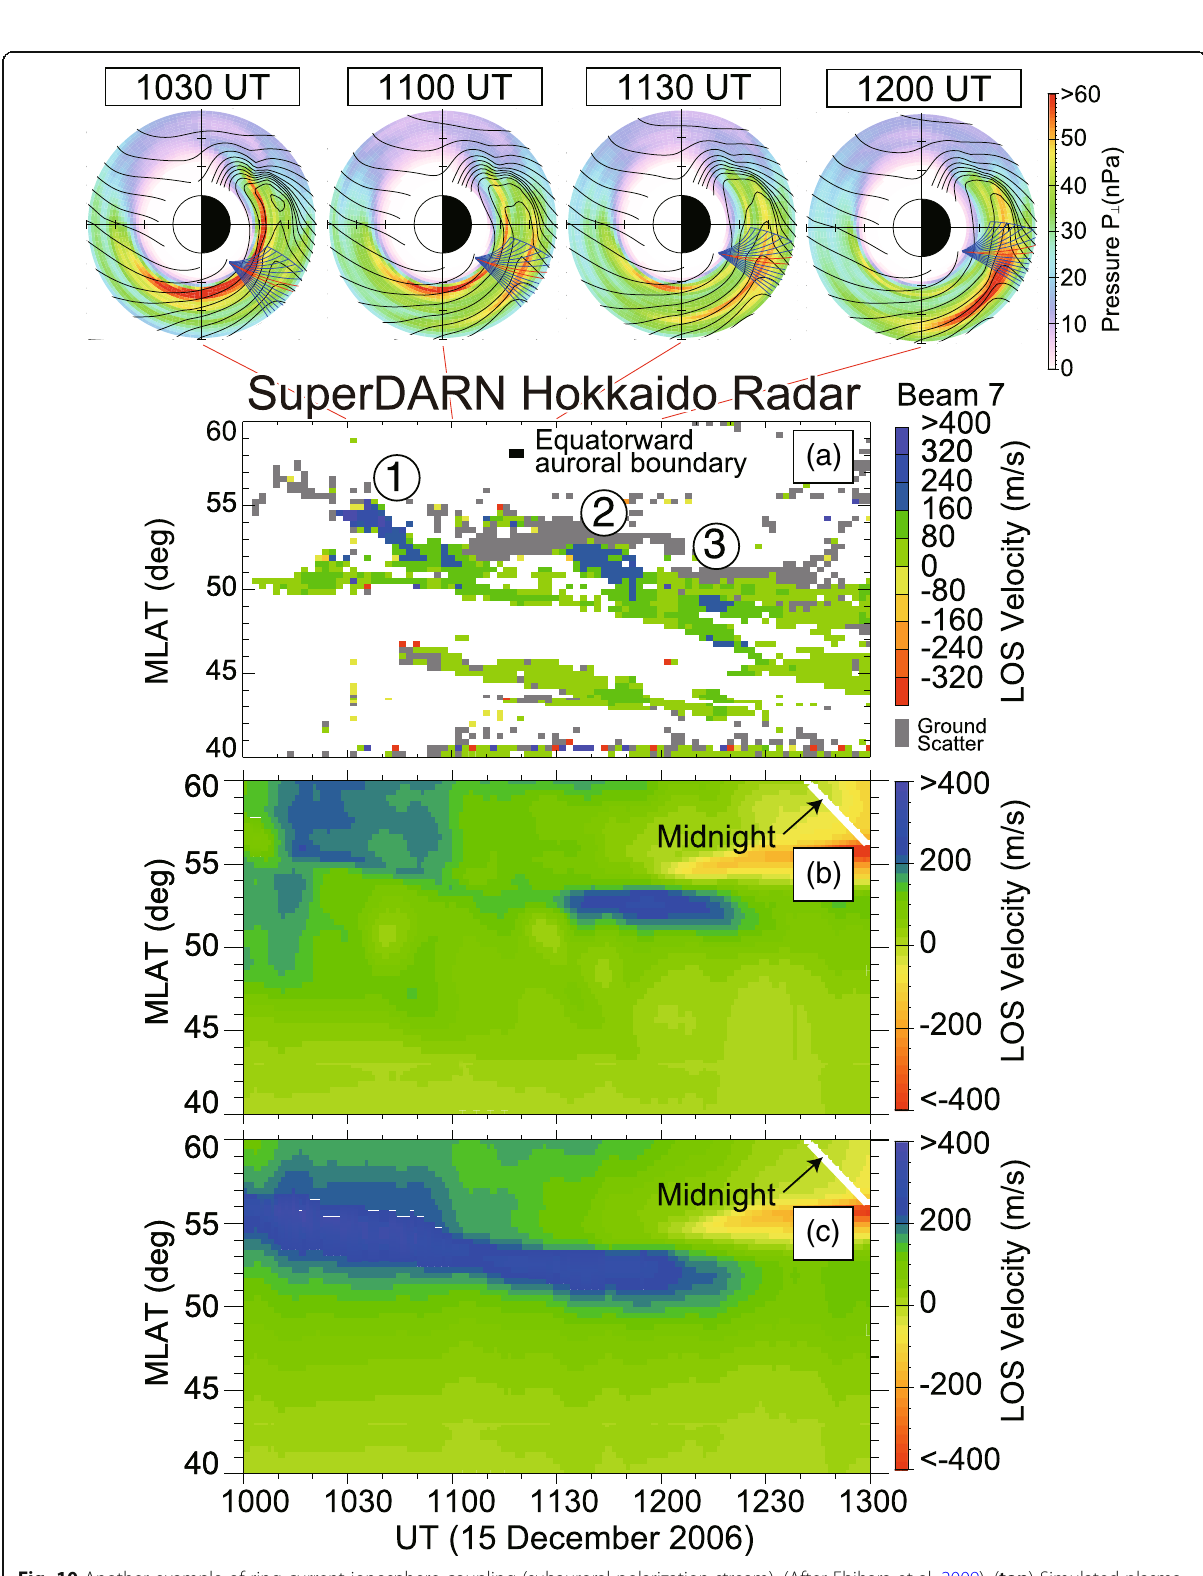
Fig. 10 Another example of ring current-ionosphere coupling (subauroral polarization stream). (After Ebihara et al. 2009). ( top ) Simulated plasma pressure. a SuperDARN Hokkaido radar observation of the line-of-sight velocity of ionospheric plasma flow. b Simulated line-of-sight velocity with time-varying plasma sheet density. c Simulated one with constant plasma sheet